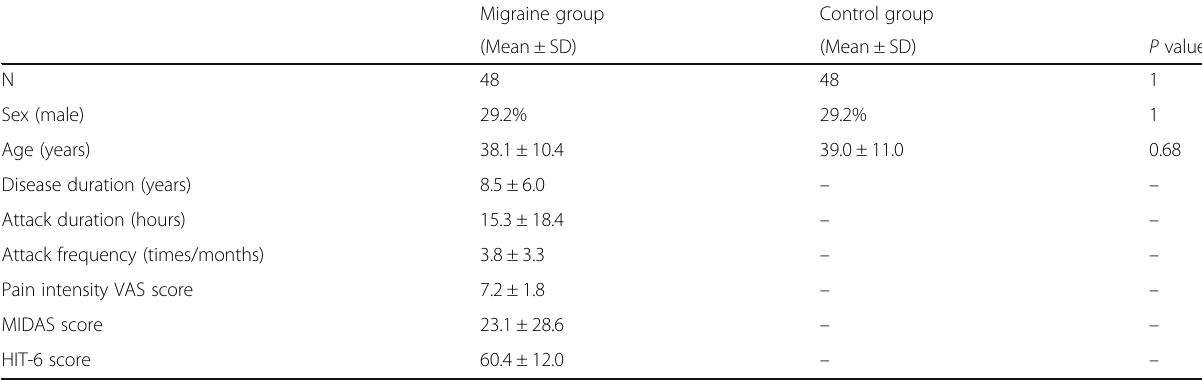
Table 1 Demographic data and clinical scores of the MWoA group and control group